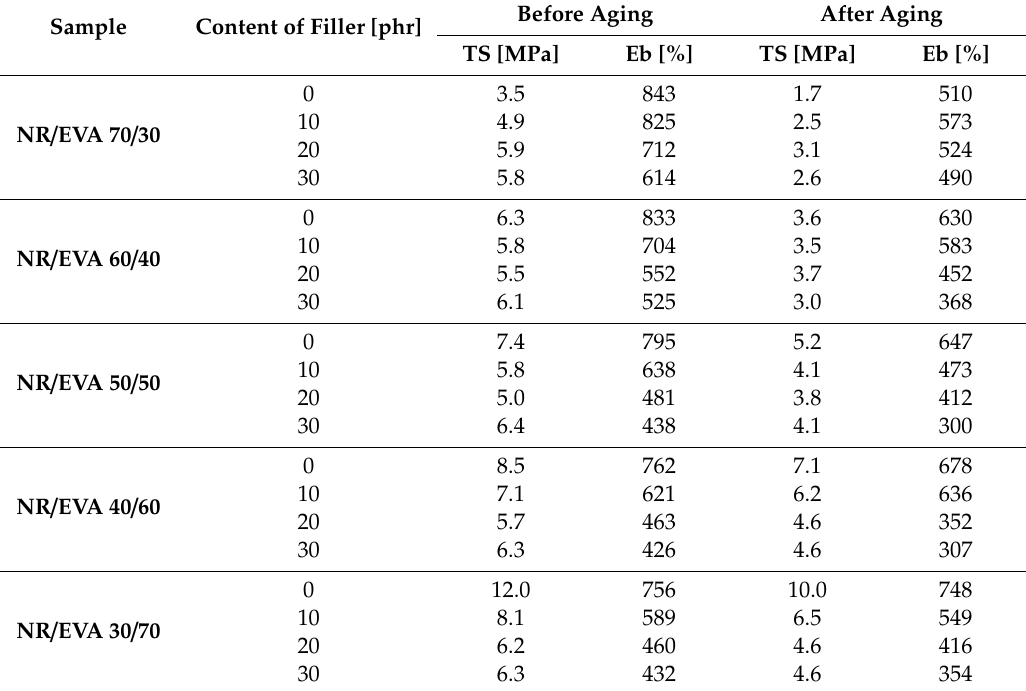
Table 2. The mechanical properties of blends before and after the aging process. Before Aging After Sample Content of Filler [phr]